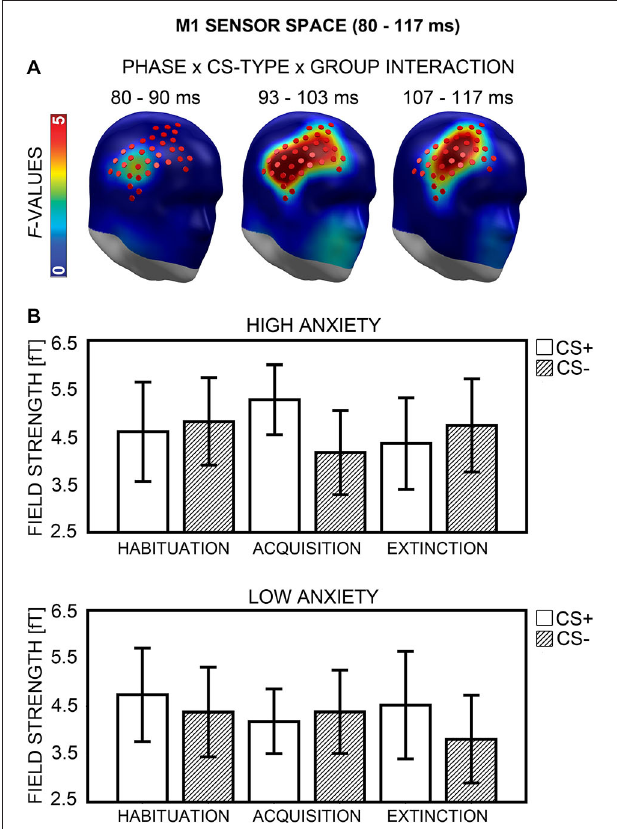
FIGURE 7 | Visualization of the M1 sensor space effect (80–117 ms) . (A) F -values for the Phase × CS-Type × Group interaction calculated for the M1 time-interval are projected onto right frontal view standard heads. Red disks visualize the sensor locations used for post hoc statistical analyses. (B) Mean field strengths (95% confidence intervals) are shown for paired (CS+; white bars) and unpaired (CS − ; striped bars) stimuli for the high and low anxiety groups and the three conditioning